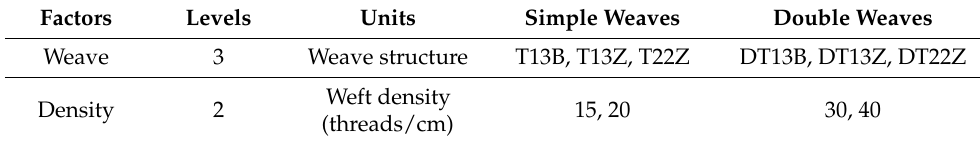
Table 4. Factors of statistical designs of experiments for simple and double weaves. Factors Levels Units Simple Weaves Double Weaves Weave 3 Weave structure T13B, T13Z, T22Z DT13B, DT13Z, DT22Z Weft density Density 2 15, 20 30, (threads/cm)